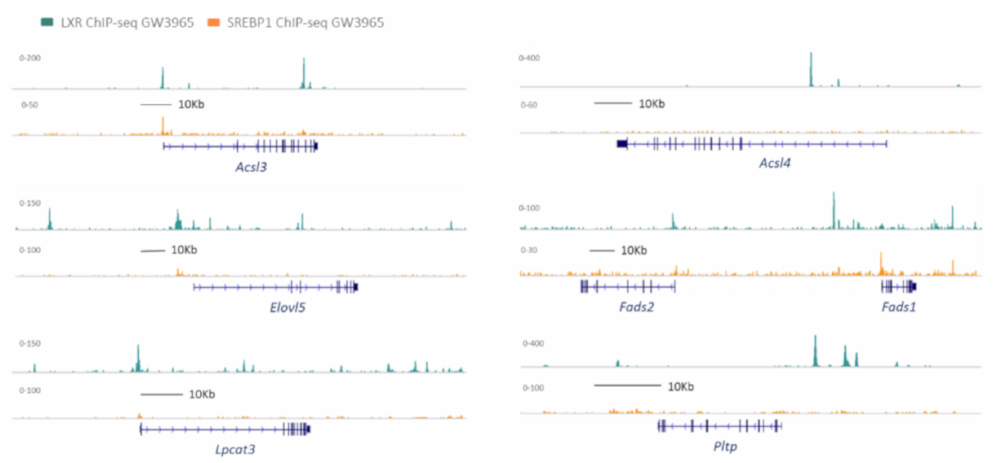
Figure 2. UCSC genome browser tracks depicting LXR and SREBP1 ChIP-Seq peaks (normalized tag counts) at genes involved in PUFA and phospholipid metabolism in mouse macrophages treated with GW3965. Images created from data by Oishi et al. Cell Metab. 2017 Feb 7;25(2):412-427 (GSE79423)